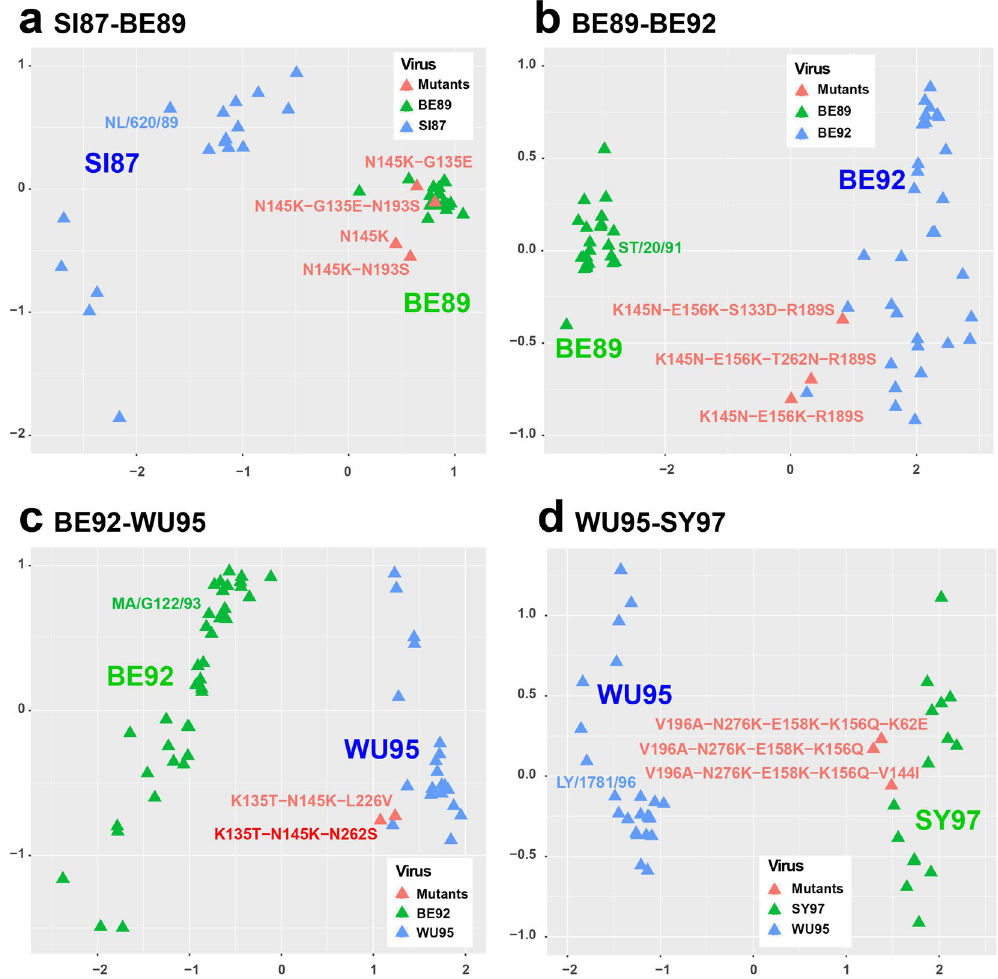
Figure 5. Antigenic cartographies to illustrate the key mutations driving the 4 antigenic drift events including ( a ) SI87-BE89, ( b ) BE89-BE92, ( c ) BE92-WU95, and ( d )